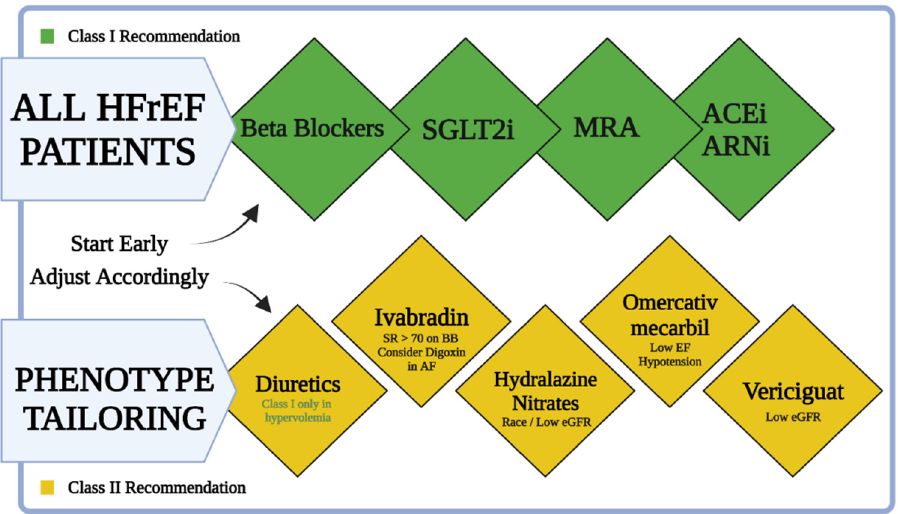
Figure 4. A simplified chart for treatment of HFrEF patients. All HFrEF patients should be started on beta-blockers, SGLT2i, MRAs, and ARNi (or ACEi) as soon as possible after diagnosis. Ivabradine should be considered in patients already on beta-blockers with sinus rhythm (SR) and heart rate > 70. Hydralazine and isosorbide dinitrate should be considered in self-identified black patients with LVEF < 35% despite optimal treatment and may be considered in those who cannot tolerate ACEi, ARB, or ARNi treatment. Omecamtiv mecarbil is a treatment option for patients with hypotension and low eGFR. Vericiguat may be considered in patients with NYHA class II–IV who have worsening HF and low eGFR despite optimal treatment.